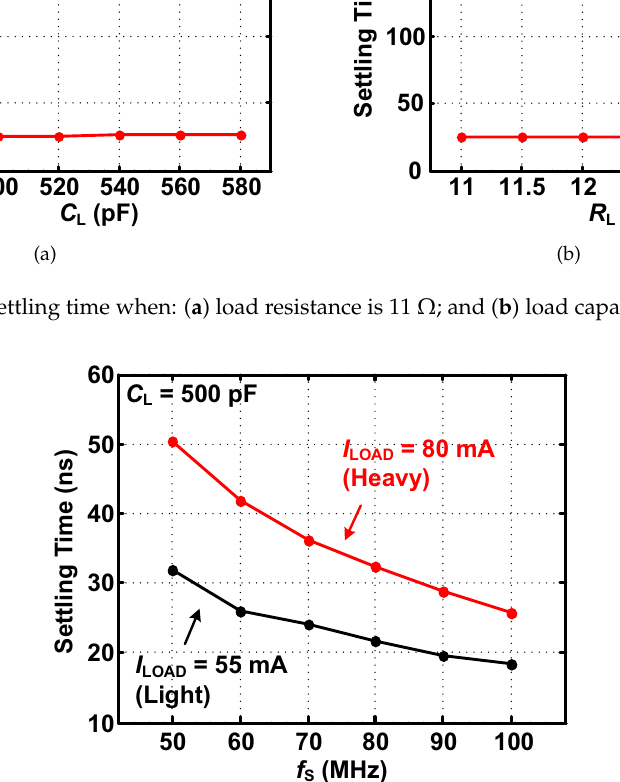
Figure 12. The settling time under the variations of sampling frequency and load